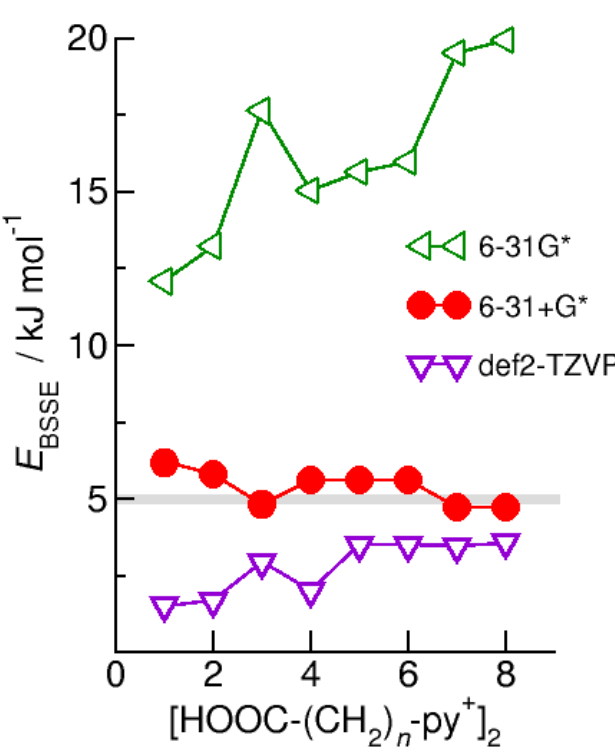
Figure 6. Basis set superposition error (BSSE) calculated for the cationic dimers (HOOC − (CH 2 ) n − py + ) 2 with n = 1–8 obtained at the B3LYP–D3 level of theory and 6–31G*, 6–31+G*, and def–TZVP basis sets, respectively. Obviously, the counterpoise (CP) approach used here is unreliable for correcting the BSSE in charged systems as reported in the literature [69]. Nevertheless, our calculations show that small Pople basis sets including diffuse function (here 6–31+G*) are well balanced, reducing the BSSE to less than 10% of the overall H-bond energy ( ∆ E = − 58.5 kJmol − 1 ), which is known for molecular systems [77,78].